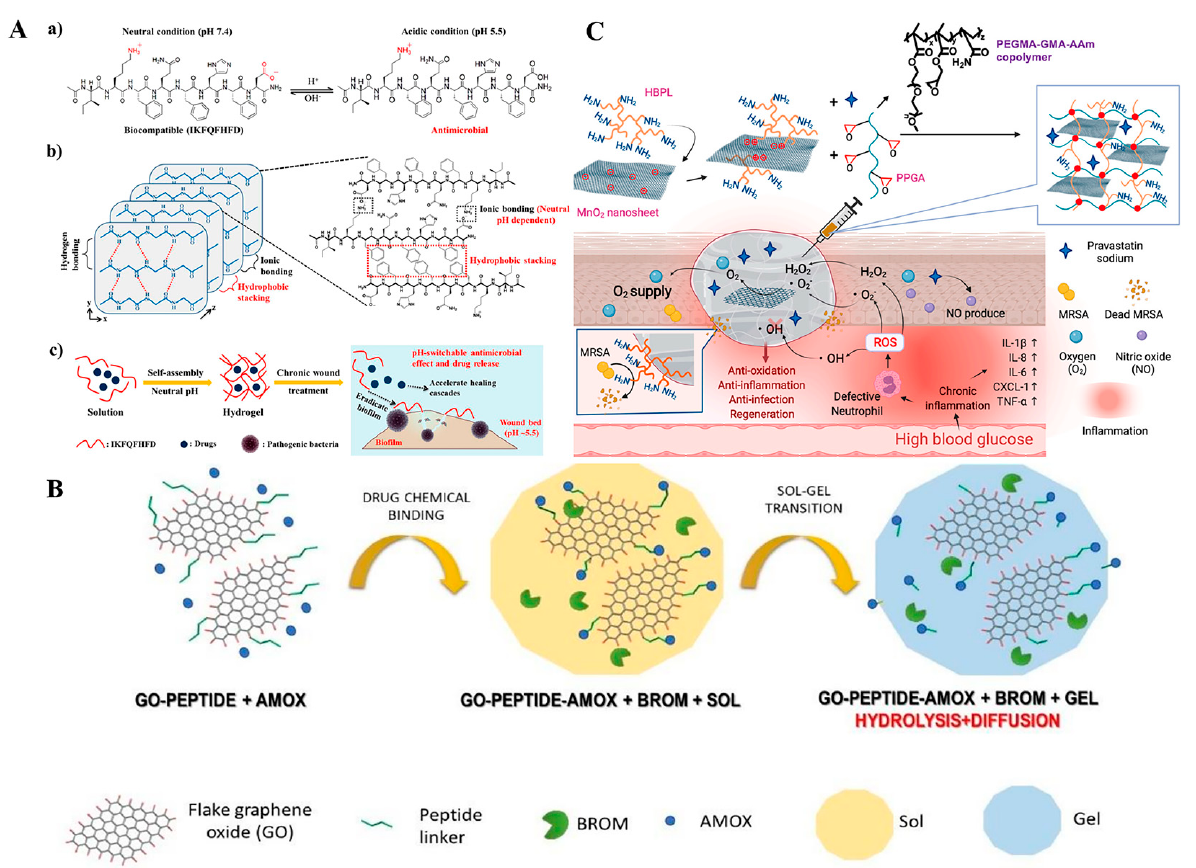
Figure 6. Endogenous stimuli-responsive nanocomposite hydrogel wound dressings for antibacterial therapy. ( A ) Schematic illustration of pH-switchable antimicrobial peptide (IKFQFHFD)-based nanofiber hydrogel wound dressing. ( a ) Chemical structure of IKFQFHFD under neutral and acidic conditions; ( b ) Proposed molecular arrangement of IKFQFHFD to form self-assembled supramolec-